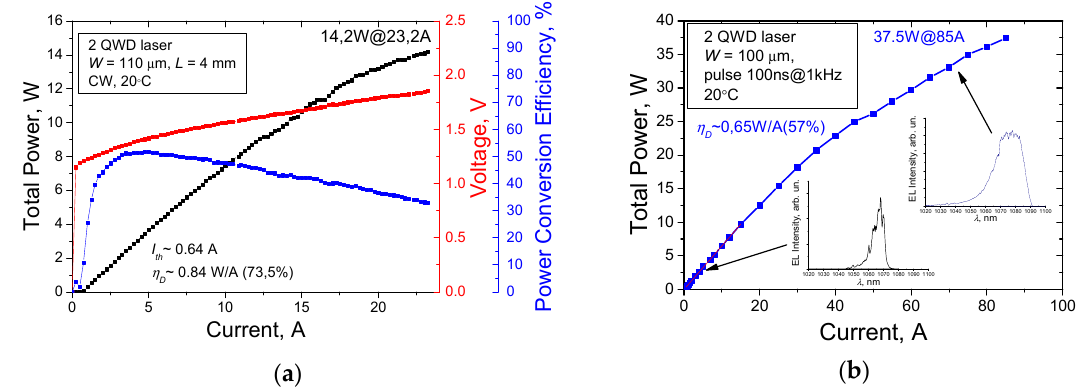
Figure 15. Dependencies of CW output power (left axis), voltage (right red axis), and power conversion efficiency (right blue axis) at room temperature on injected current for an edge-emitting laser based on 2 QWD layers ( a ); dependence of pulsed output power on injected current. Insets: spectra at two different currents ( b ).